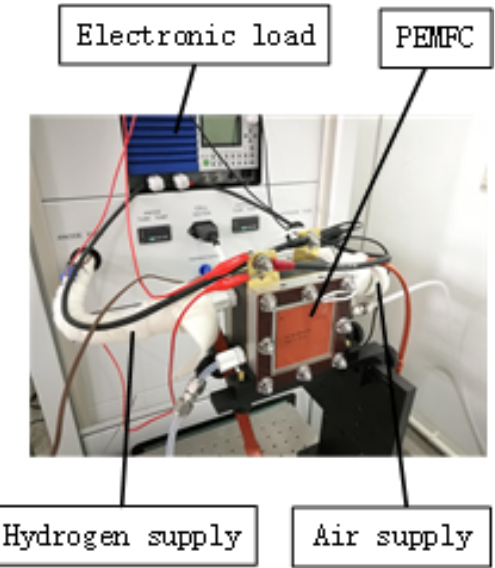
Figure 5. Proton exchange membrane fuel cell (PEMFC) test setup. Table 1. Technical parameters of two membrane electrode assemblies (MEAs) used in the